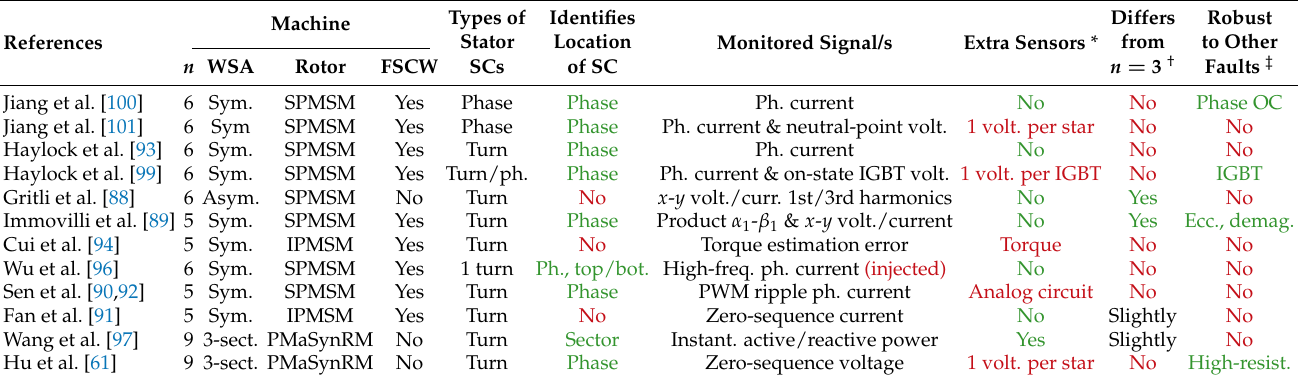
Table 8. Methods for detecting stator SCs (Section 5.2) in multiphase applications in the literature. Types of